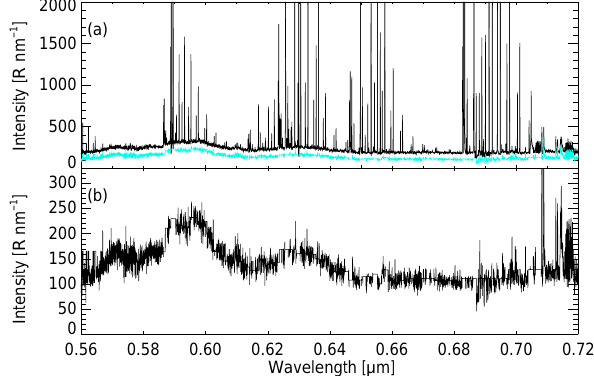
sky spectrum with all its emissions. The FeO continuum, with possi- ble contamination by NiO and NO + O, is overplotted in cyan. The difference is due to the removal of all airglow emission lines, zo- diacal light, and scattered star- and moonlight. (b) Shows the same FeO spectrum. It has an exposure time of 3600s and a resolving power of about 7450. The ordinate shows the emission intensity in rayleighs per nanometre (1R = 10 6 photonscm − 2 s − 1 ), while the abscissa shows the FeO emission regime in